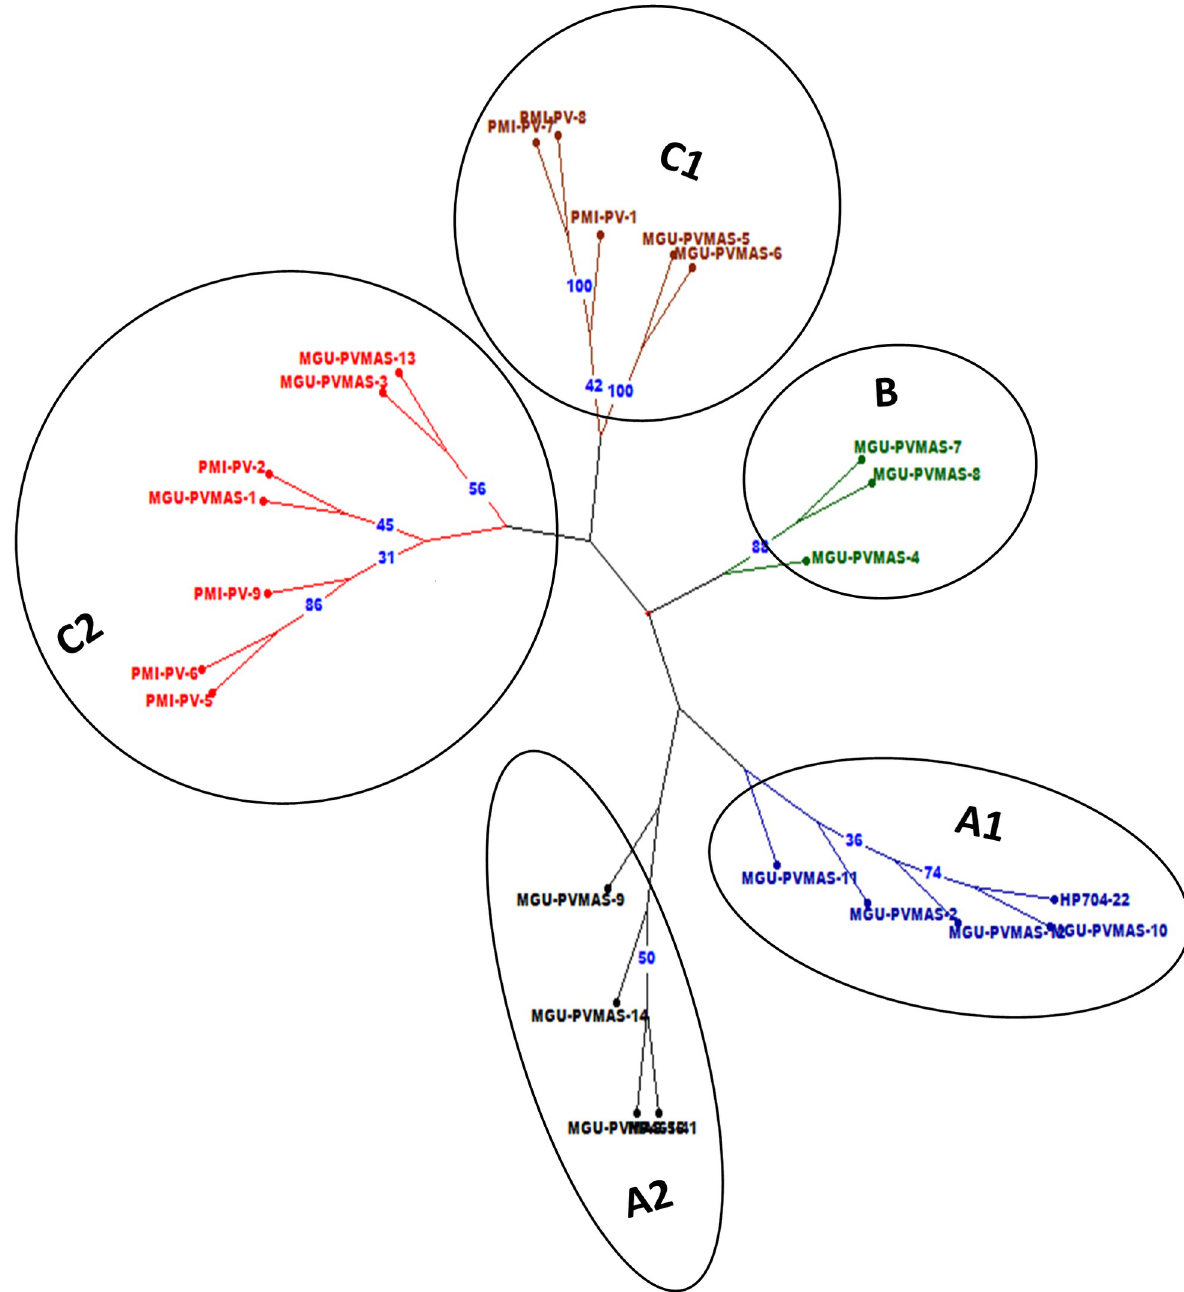
Fig 2. Cluster analysis depicting genetic dissimilarity of the 24 inbreds. Three major clusters viz., A, B and C while 1 and 2 represent sub-clusters within each major cluster. Bootstrap value � 30 is presented. https://doi.org/10.1371/journal.pone.0245497.g002 7.51 to 14.90 μ g/g with an average of 10.37 μ g/g. The mean concentration among low-proA and high-proA checks was 3.13 and 12.04 μ g/g, respectively. Among the experimental hybrids, MGUH-57 with a proA concentration of 14.90 μ g/g was the best combination, closely followed by MGUH-1 (14.69 μ g/g), MGUH-52 (14.60 μ g/g) andMGUH-27 (14.36 μ g/g).